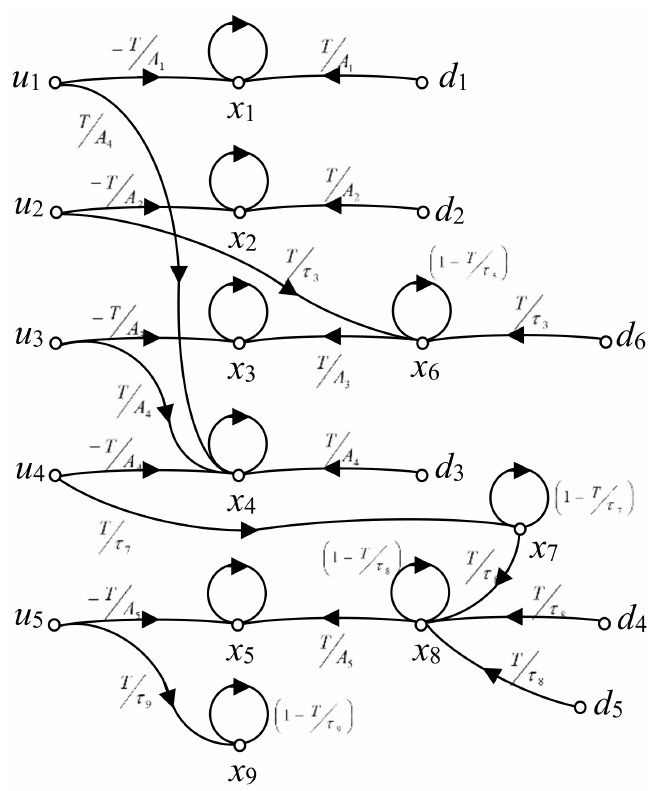
Figure 3. Direct graph of the sewer.